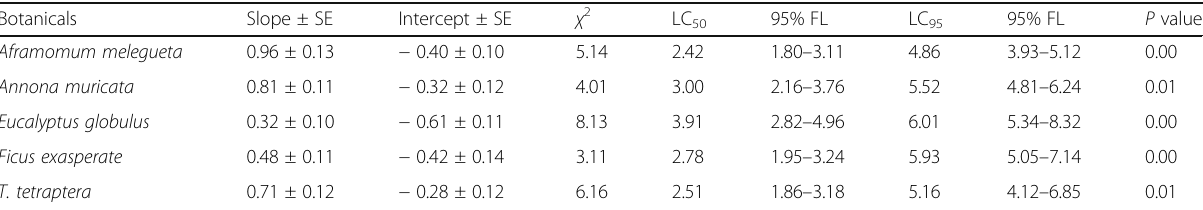
Table 4 Lethal concentrations (LC 50 and LC 95 ) of essential oils on C. maculatus at 48 h of exposure Botanicals Slope ± SE Intercept ± SE χ 2 P value Aframomum melegueta Annona muricata Eucalyptus globulus 0.32 ±